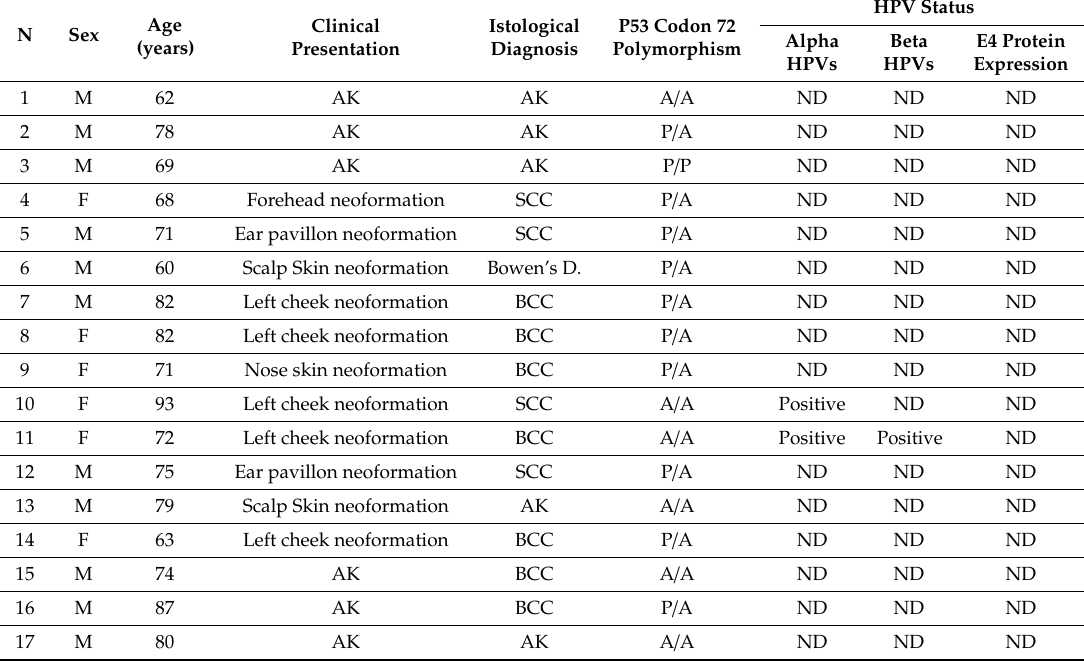
Table 1. Synopsis of patients’ clinical presentation, histopathological diagnoses, p53 and HPV status. Clinical Istological N Age (years) Presentation